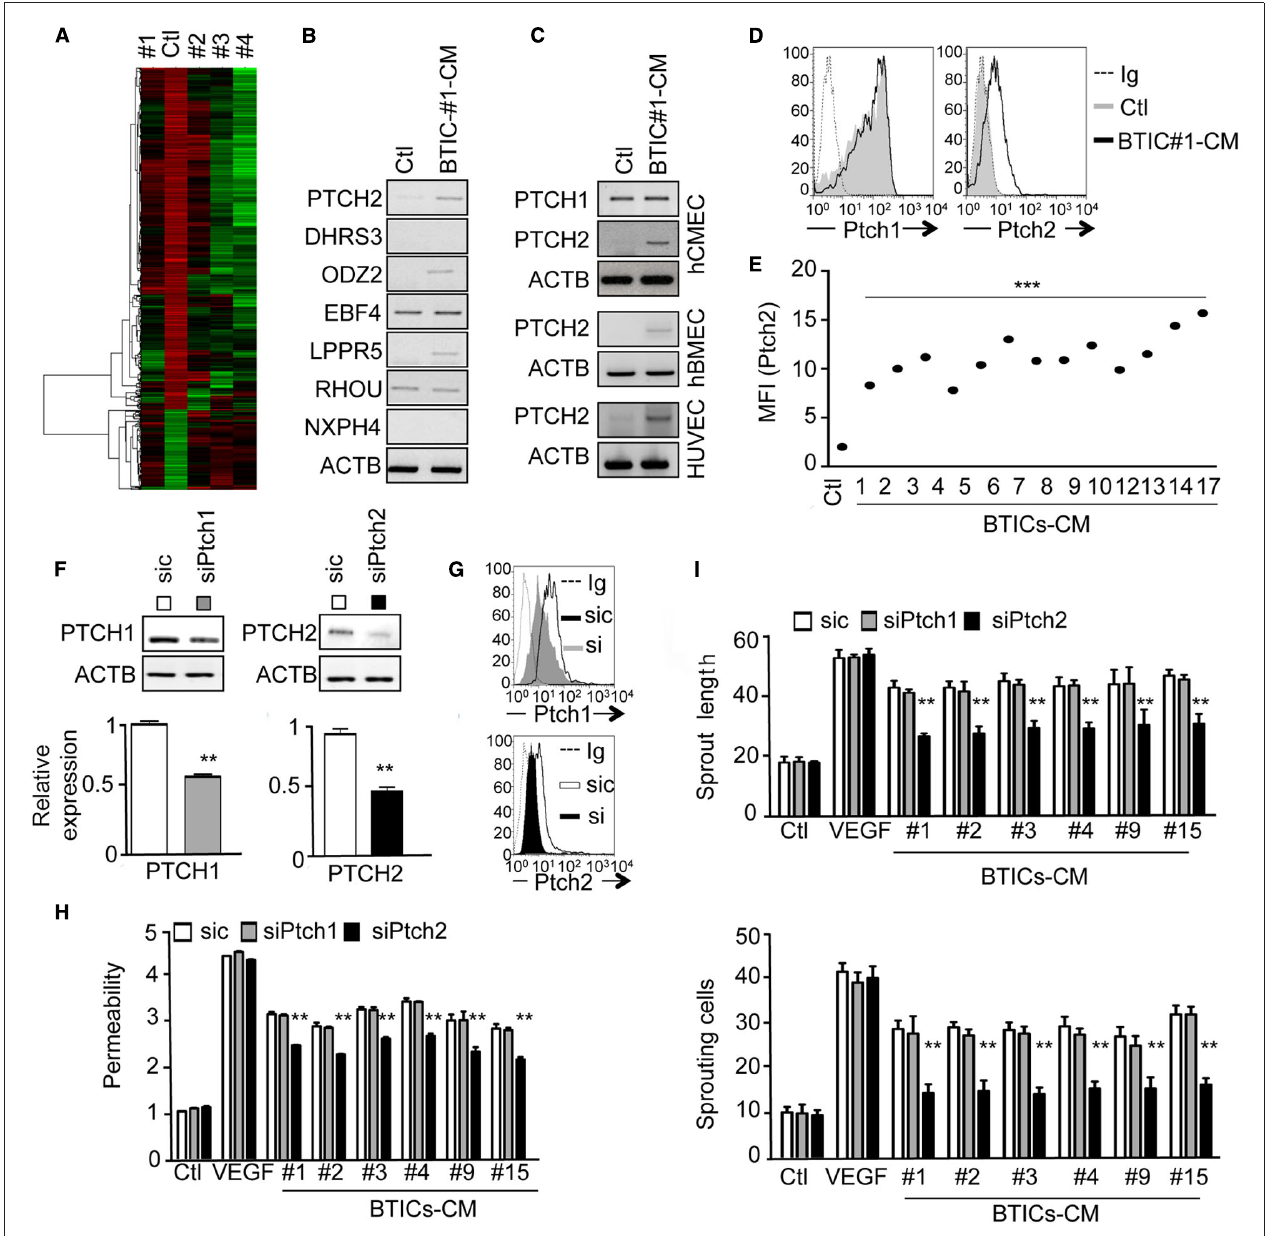
FIGURE 2 | The Hedgehog receptor Ptch2 is up-regulated in BTIC-CM-exposed brain endothelial cells. (A) Gene array analysis of hCMEC/D3 cells exposed to BTIC-derived conditioned media for 24 h. Untreated endothelial cells were used as control. (B) Gene array confirmation by RT-PCR of seven up-regulated genes common to all treated conditions. Actin (ACTB) was used as a reference gene. (C) RT-PCR analysis of PTCH2 expression in three different types of endothelial cells. Confluent monolayers of hCMEC/D3, hBMEC, and HUVEC cells were exposed to BTIC-derived conditioned media for 24 h, and PTCH2 expression analyzed by RT-PCR. Actin (ACTB) was used as a reference gene. (D,E) hCMEC/D3 cells were analyzed by flow cytometry for total Ptch1 and Ptch2 expression before (Ctl) and after BTICs-derived conditioned media stimulation (BTIC-CM, 24 h). In (D) , dashed histograms correspond to the isotype-matched control (Ig) and gray and black histograms show antibody staining of control and stimulated conditions, respectively. Mean of fluorescence of 10,000 events (MFI) for Ptch2 expression in untreated (Ctl) versus stimulated (BTIC-CM) endothelial cells is shown in (E) . (F–H) hCMEC/D3 cells were transfected with control (sic) or siRNA against Ptch1 (siPtch1) or Ptch2 (siPtch2). For Ptch2 silencing, 48 h after receiving the siRNA, endothelial cells were further stimulated with BTIC-CM for another 24 h in order to induce Ptch2 expression. (F) Ptch1 and Ptch2 expression were analyzed by RT-PCR. Actin (ACTB) was used as a reference gene. (G) Ptch1 and Ptch2 expression were analyzed by flow cytometry. Dashed histograms correspond to the isotype-matched control (Ig) and gray and black histograms show antibody staining in endothelial cells treated as indicated. (H) Permeability of endothelial cells was assessed. (I) hCMEC/D3 cells were also tested for their sprouting capacity. The number of sprouting cells and mean sprout length were determined. *** p < 0.001, ** p < 0.01 by analysis of variance (ANOVA). Each panel is representative of at least two independent experiments.